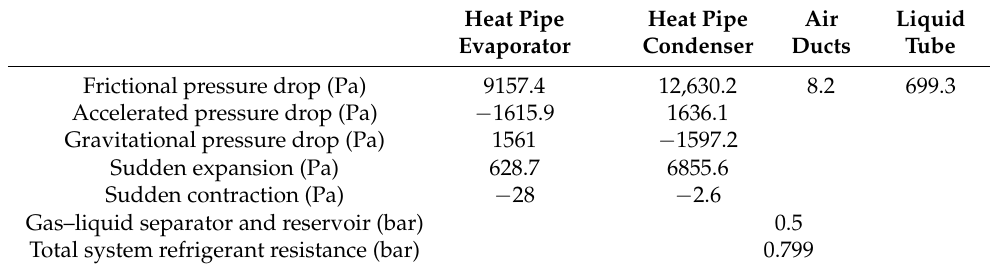
Table 7. Pressure drop of refrigerant flow in heat pipe